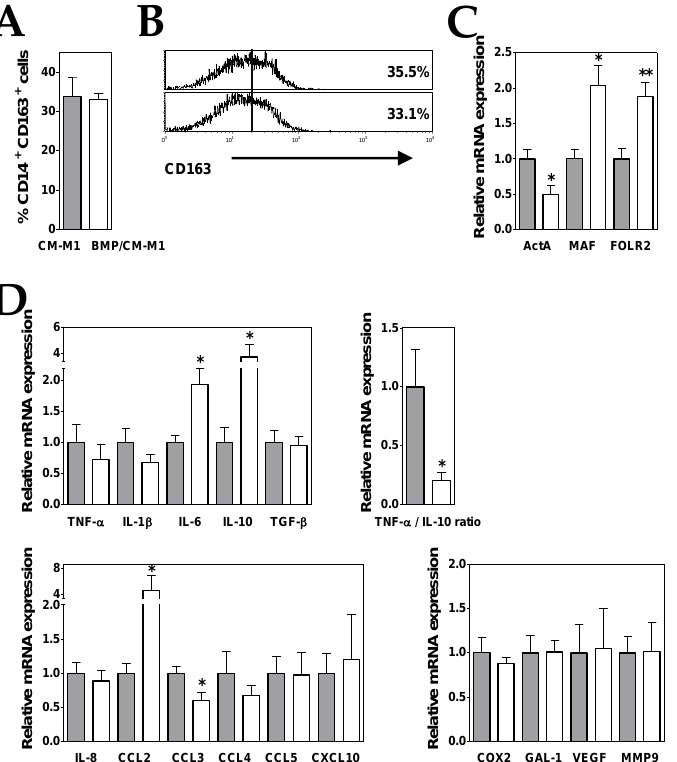
Figure 4. BMP4 overexpression in ALL cells potentiates their ability to generate M2-like MØs. ( A ) Percentages of CD14 + CD163 + MØs generated from monocytes cultured for five days with GM-CSF plus conditioned media from control (grey bars; CM-M1) and BMP4-transduced (white bars; BMP / CM-M1) ALL cells. Data represent the mean ± SEM of four independent experiments. ( B ) Representative histograms showing CD163 expression in CM-M1 and BMP / CM-M1 MØs. ( C , D ) Real-time PCR quantification of mRNA levels in MØs di ff erentiated from monocytes after three days of culture with GM-CSF plus conditioned media from control (grey bars) and BMP4-transduced (white bars) ALL cells. Relative mRNA expression was calculated by dividing all individual data by the mean expression in CM-M1 MØs. Results represent the mean ± SEM of three to five independent experiments. Asterisks represent statistically significant di ff erences between CM-M1 and BMP / CM-M1 MØs (* p ≤ 0.05 and ** p ≤ 0.01; by Mann–Whitney test).